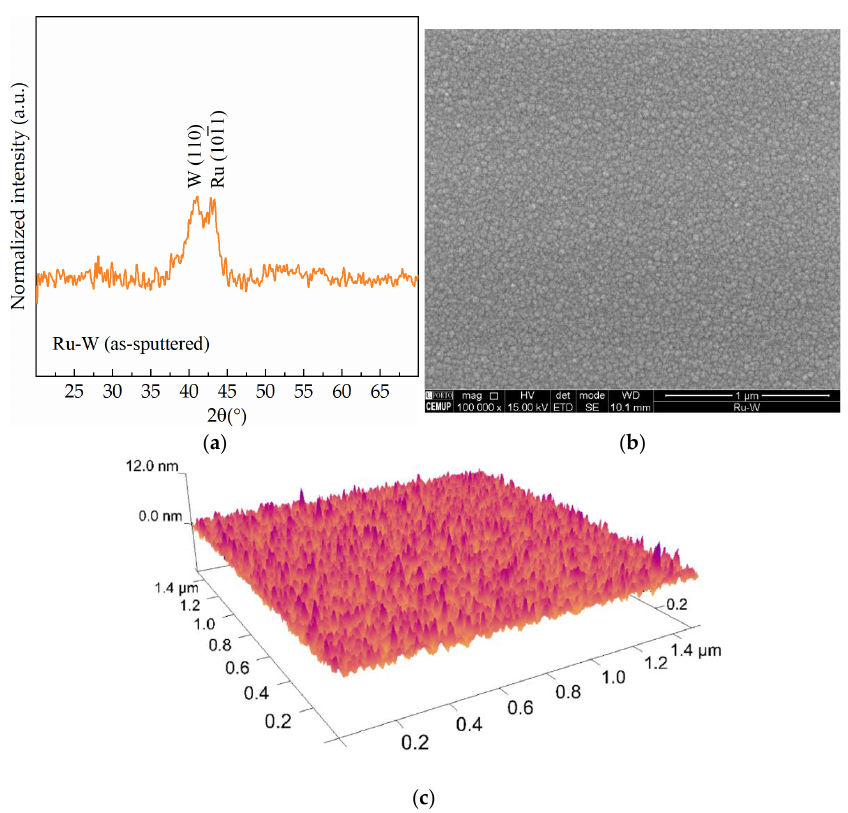
Figure 2. As-sputtered Ru – W film X-ray diffractogram ( a ), and its surface observed by SEM ( b ) and by AFM ( c ). Table 1. Specimen tag names and respective electroplating conditions.